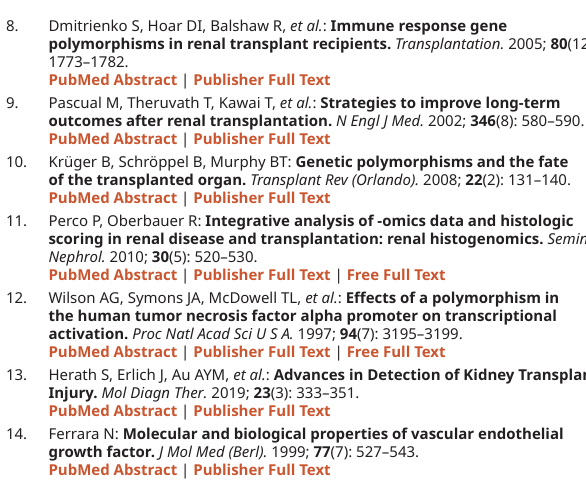
- S1 Table Overall, modified and subgroup outcomes for VEGF1. - S2 Table Overall, modified and subgroup outcomes for VEGF2. - S3 Table Overall, modified and subgroup outcomes for